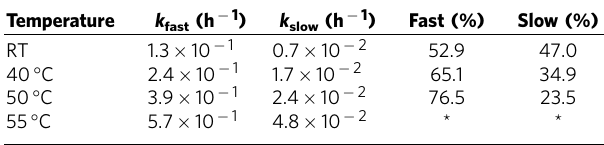
Table 1 | Rate constants of HDX for the fast and slow exchanging parts together with the contributions of the fast and slow process at different temperatures (RT ¼ room temperature).